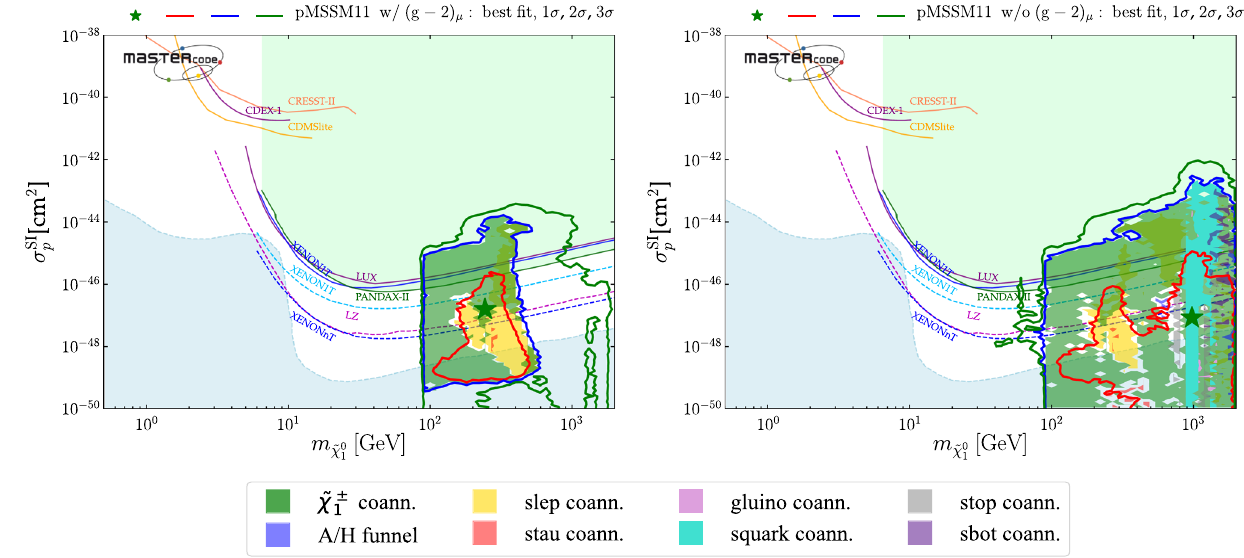
,σ SI ) with(leftpanel)andwithout(rightpanel) Fig. 20 Planesof ( m ˜ χ 0 and the combined limit is indicated by a black line with green shading p 1 above. The projectedfuture 90% CL exclusionsensitivitiesof the LUX- the ( g − 2 ) μ constraint applied, where the values of σ SI p displayed are Zeplin (LZ) [168] and XENON1T/nT [169] experiments are shown as the nominal values calculated using the SSARD code. The upper limits solid purple and dashed blue lines, respectively, and the neutrino back- established by the LUX [4], XENON1T [6] and PandaX-II [3] Collab- ground ‘floor’ is shown as a dashed light-blue line with a shading of the orations are shown as green, magenta and blue contours, respectively, same colour below